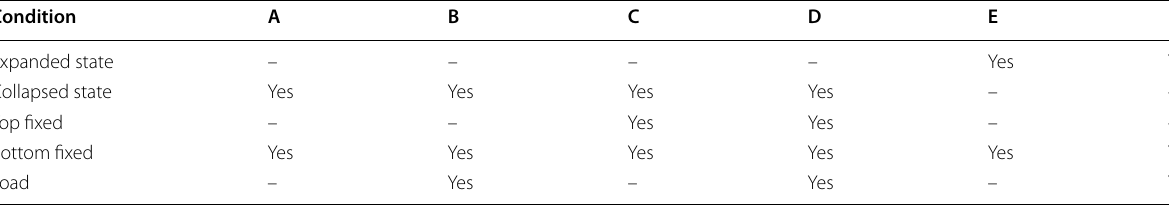
Table 3 Different states and loads of